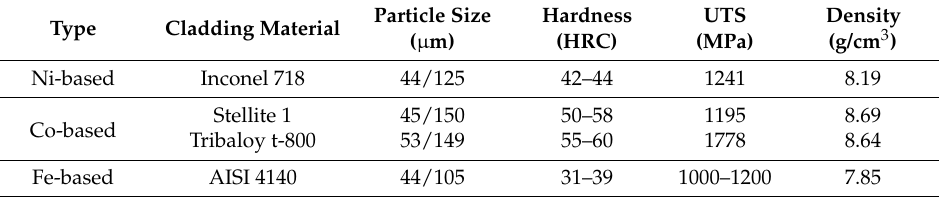
Table 1. Properties of selected materials. AISI: American Iron and Steel Institute.